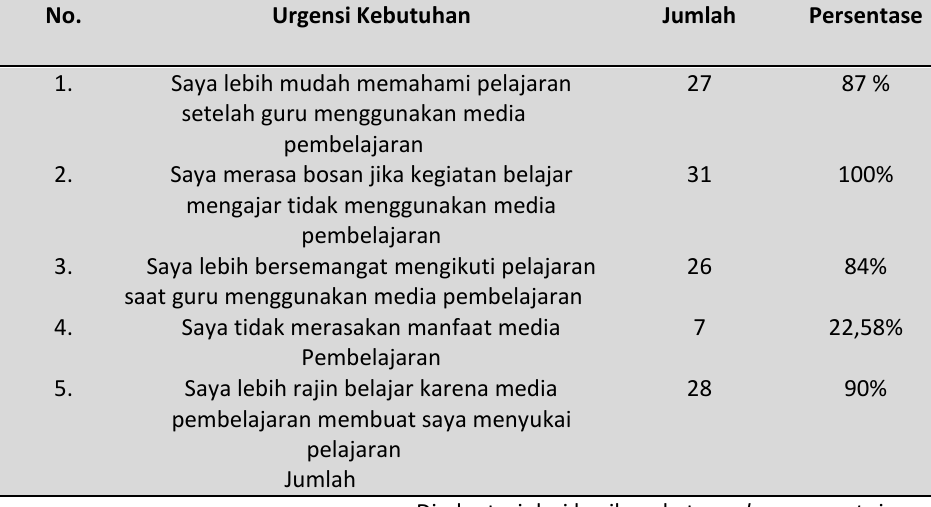
Tabel 1 . Need Assesment Pengembangan Media Komik Responden